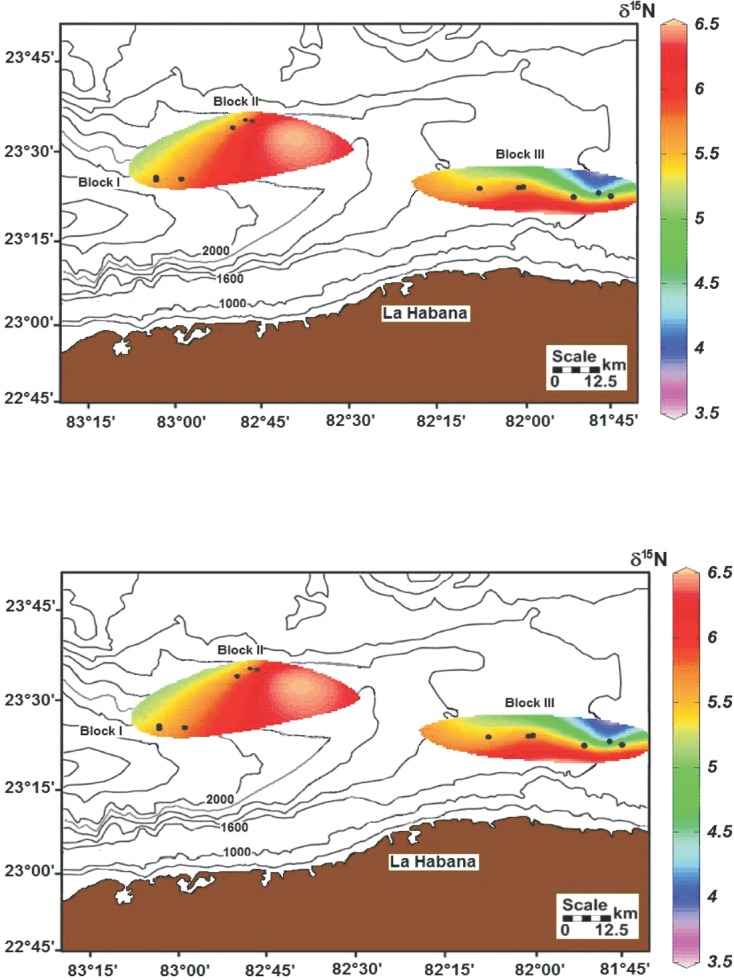
δ13Corg and δ15N.Spatial distribution of δ13Corg and δ15N values in surface sediments collected from the three Blocks examined in the Southern Florida Straits off the insular slope of the NW coast of Cuba.